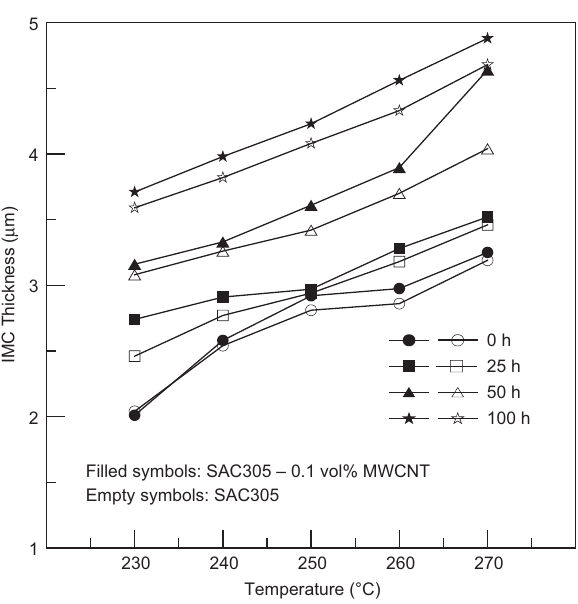
Figure 8 The variation of IMC thickness of Sn-Ag-Cu-MWCNT systems with soldering